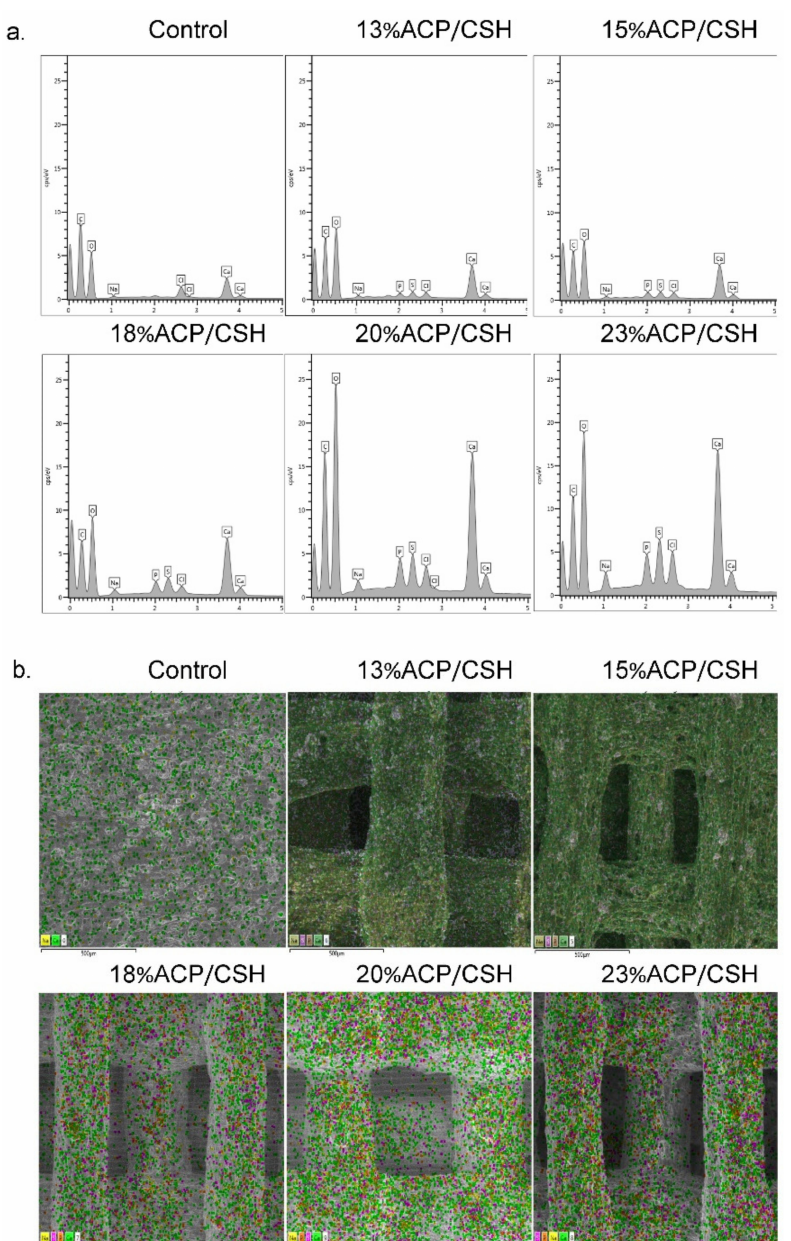
Figure 3. ( a ) Ion complement graphs show the amounts of C, O, Ca, P, Na, S, and Cl ions. ( b ) SEM mapping shows ion dispersion (green is Ca, orange is P, yellow is Na, pink is S, and red is Cl). Mapping of the SEM images revealed the distribution of each ion on the scaffolds. The pigment intensities of the Ca, P, Na, and S ions tended to increase from the control to the 23%ACP/CSH group. All ions displayed a homogenous dispersion on the filament areas (Figure